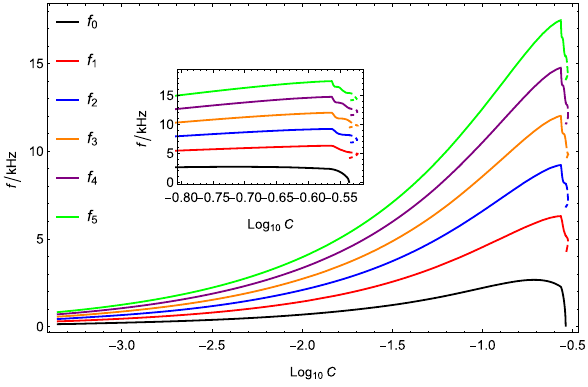
Fig. 5 The eigenfrequencies f n = ω n / 2 π of n = 0 , 1 , 2 , 3 , 4 , 5 modes versus compactness C = M / R of multiquark core at energy density scale (cid:3) s = 23 . 2037 GeV/fm 3 . Solid (Dashed) line represents the frequency of the MQ core in the stable (unstable) branch